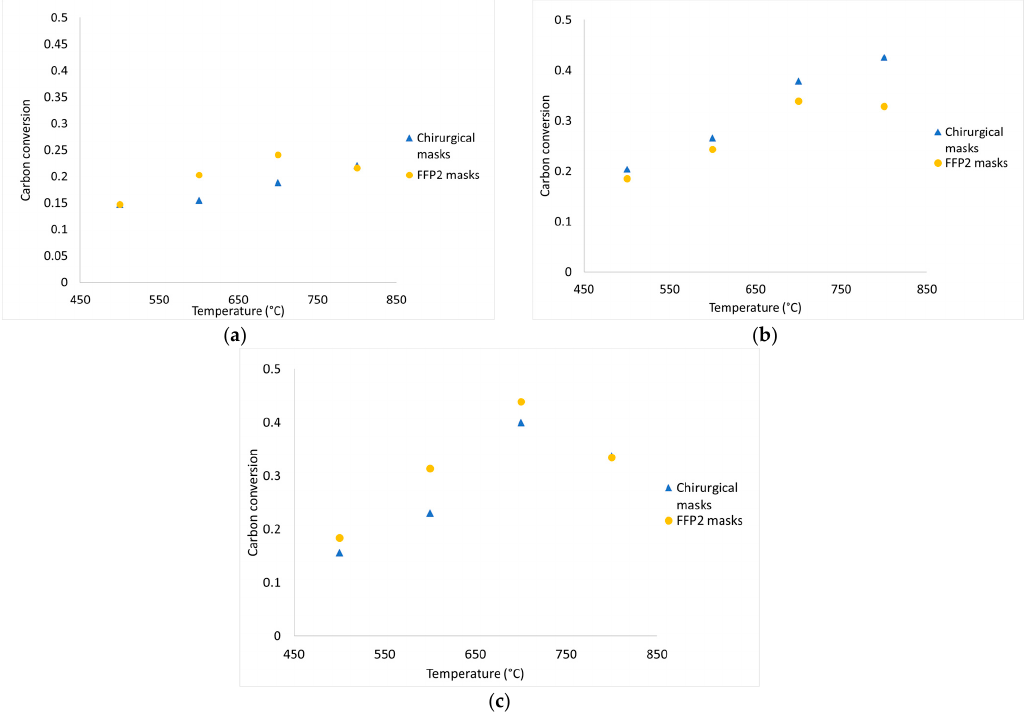
Figure 8. Experimental data of carbon conversion obtained from devolatilization tests in nitrogen atmosphere ( a ), diluted air ( b ), and diluted air using wet pellets ( c ).